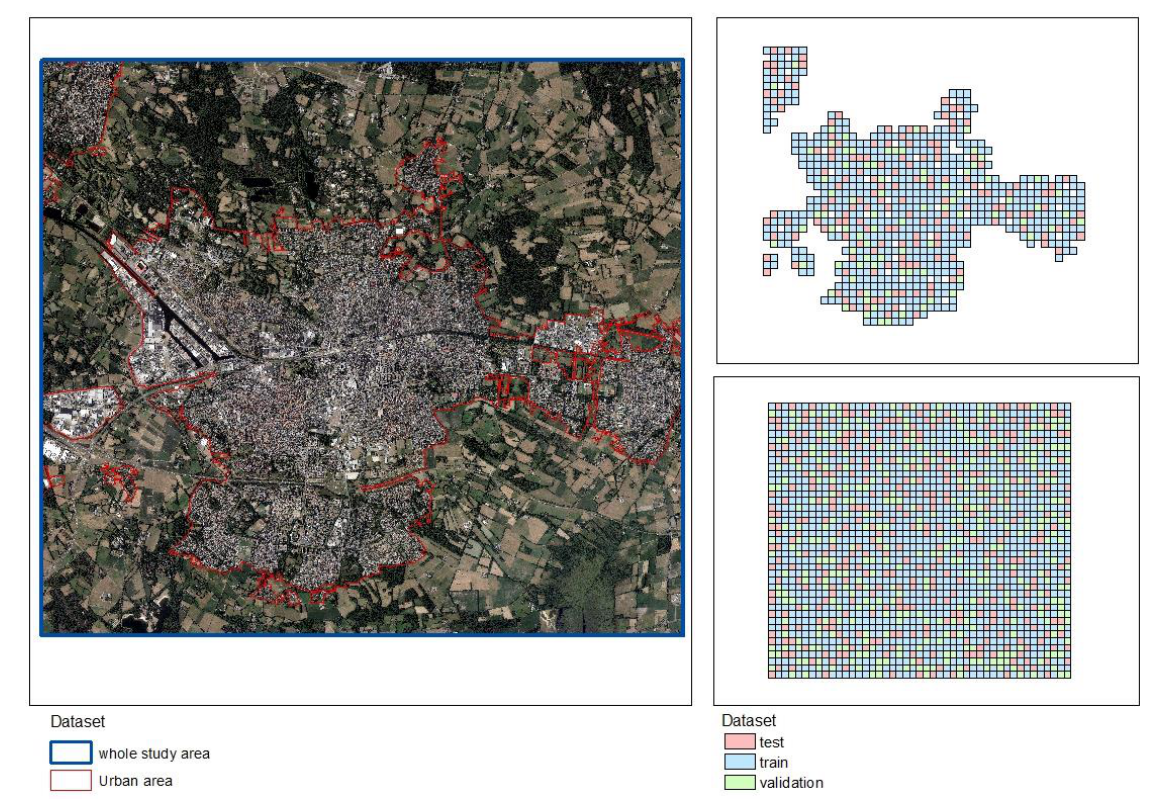
Figure 5. The entire study area is the whole image of the city of Enschede; the urban area is denoted by the red polygons (right). The right side shows the tile distribution for the urban area (upper right), and the entire study area (lower right).